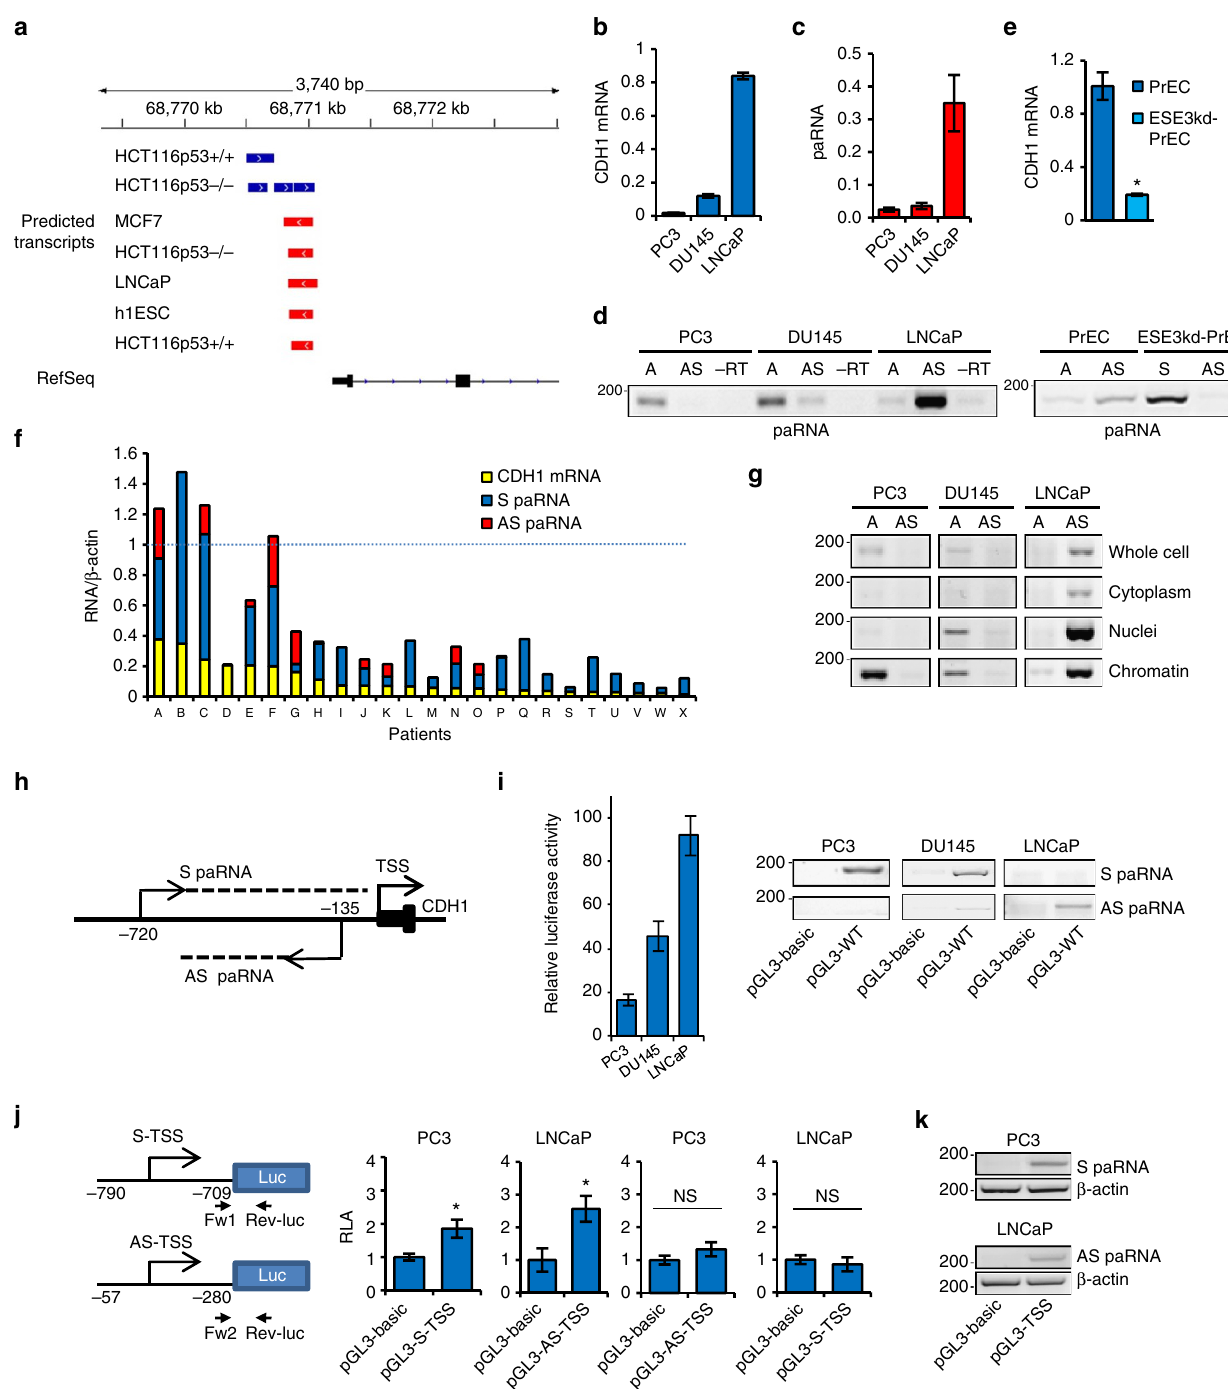
Figure 1 | Promoter-associated transcripts at the CDH1 gene locus. ( a ) Predicted promoter-proximal transcripts with sense (blue) and antisense (red) orientation relative to the CDH1 gene from GRO-Seq data in multiple cell lines. ( b , c ) Level of CDH1 mRNA ( b ) and paRNA ( c ) in prostate cancer cell lines determined by qRT-PCR. ( d ) S- and AS-paRNAs in prostate cancer cell lines determined by strand-specific RT–PCR. (cid:2) RT, control reaction without RTstep. ( e ) Levels of CDH1 mRNA and paRNAs in normal PrECs and tumorigenic ESE3kd-PrECs determined by qRT–PCR (top) and strand-specific RT–PCR (bottom). ( f ) S-paRNA (blue bars), AS-paRNA (red bars) and CDH1 mRNA (yellow bars) determined by qRT-PCR in human prostate tumours. Dotted line, CDH1 mRNA level in normal PrECs shown as reference. ( g ) Intracellular distribution of S- and AS-paRNA in prostate cancer cell lines. ( h ) S and AS transcript initiation sites in the CDH1 promoter determined by 5 0 -RACE (see Supplementary Fig. 2d). ( i ) Luciferase reporter activity (left) and promoter–proximal transcripts (right) generated from the full length CDH1 promoter construct in prostate cancer cell lines. ( j ) Schematic representation of S-TSS and AS-TSS promoter reporter constructs and luciferase activity in PC3 and LNCaP cells. ( k ) S and AS transcripts generated from S-TSS and AS-TSS constructs in PC3 and LNCaP cells determined by strand-specific RT–PCR. Positions of forward and reverse primers for RT–PCR are indicated in j . Data are mean ± s.d. of three independent determinations. Student’s t -test was used for P value assessment. * P o 0.05.